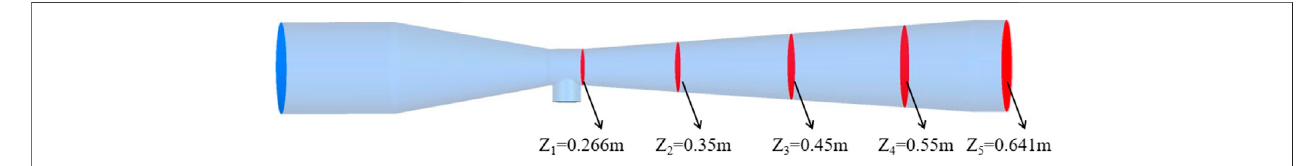
FIGURE 3 | Determination of monitoring